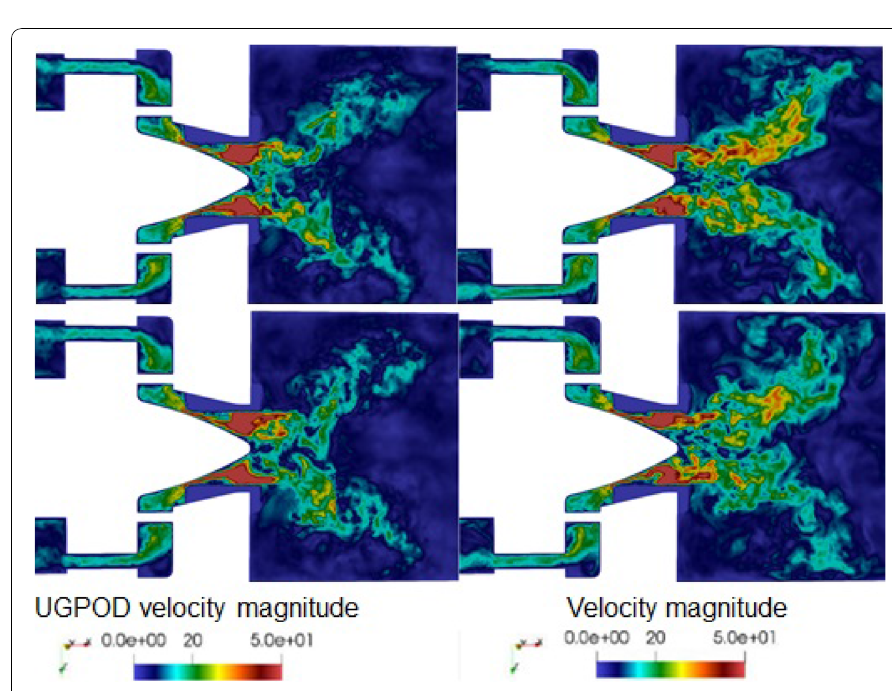
Fig. 40 One the left, two different time steps of the UGPOD applied to configuration 1. On the right, the same two time steps LES velocity fields with configuration